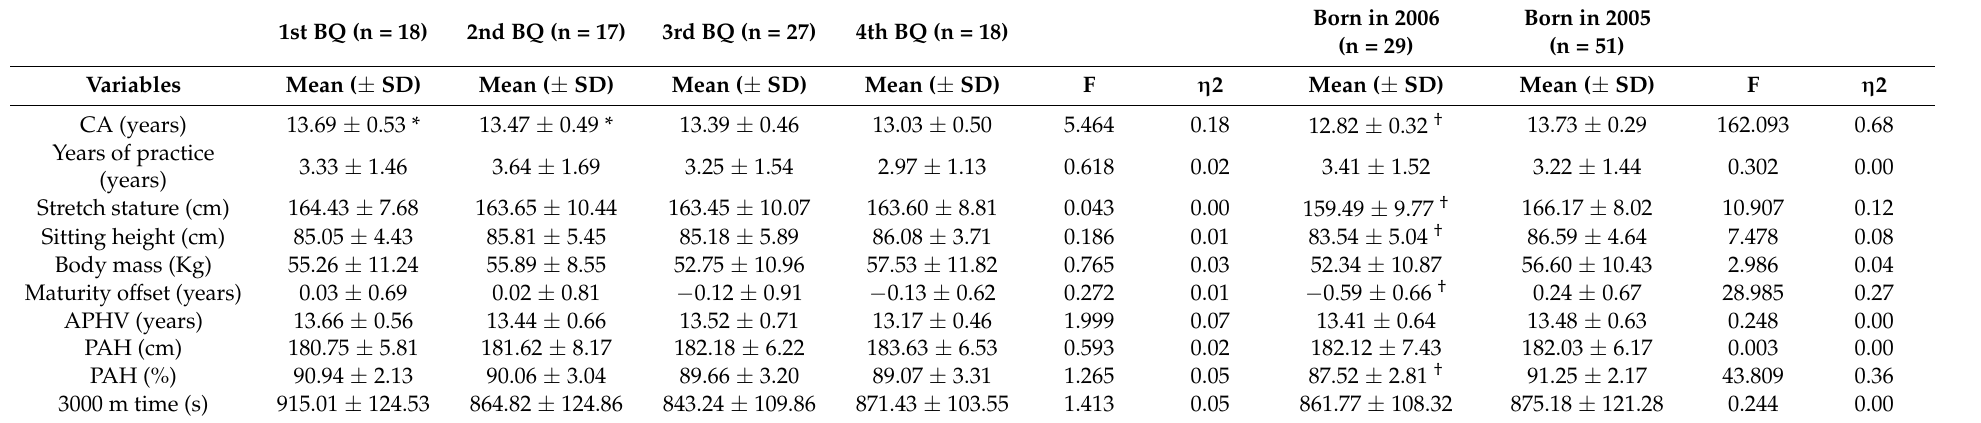
Table 3. Characteristics (means and standard deviations) of U14 kayakers by birth quarter (n = 80), year of birth (2006, n = 29 and 2005, n = 51) and results of ANOVA, and estimated effect sizes ( η 2